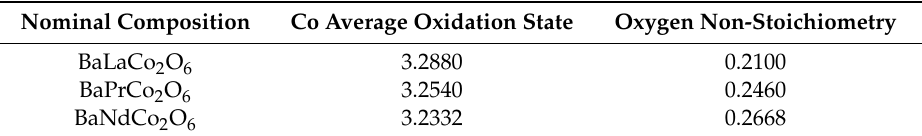
Table 3. Co average oxidation state and oxygen non-stoichiometry obtained with iodometric titration BLC, BPC, and BNC for the samples before XAS